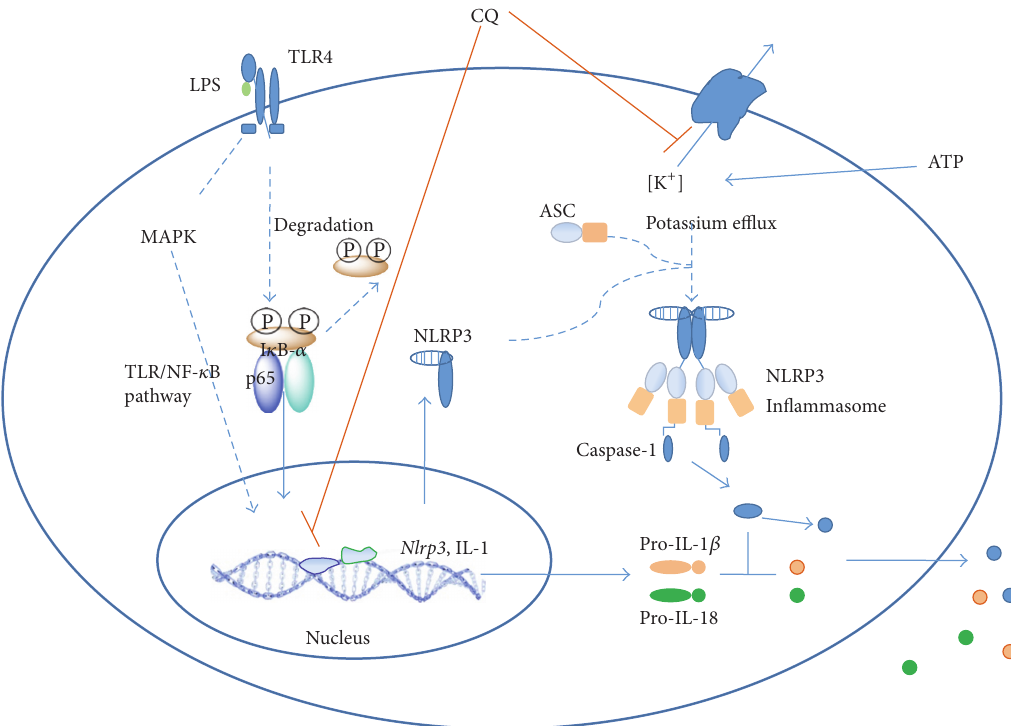
Figure 7: The proposed mechanism of CQ for the inhibition of NLRP3 inflammasome